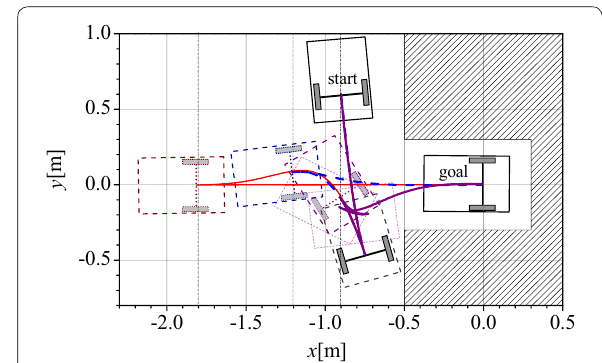
Fig. 11 States and inputs in the experiment when α is switched as α 1 0.5 8 1 Fig. 12 Experimental results with different switching = → → →